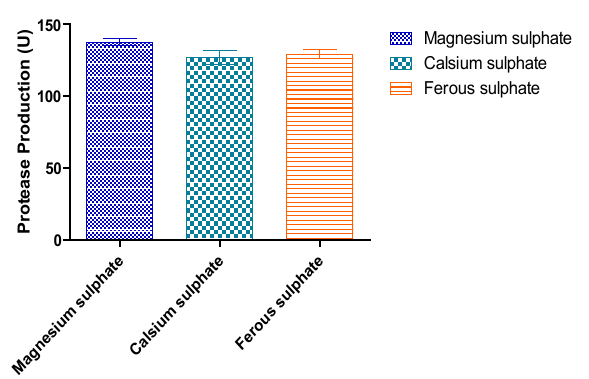
Fig. 2. Effect of different nitrogen sources on alkaline protease production